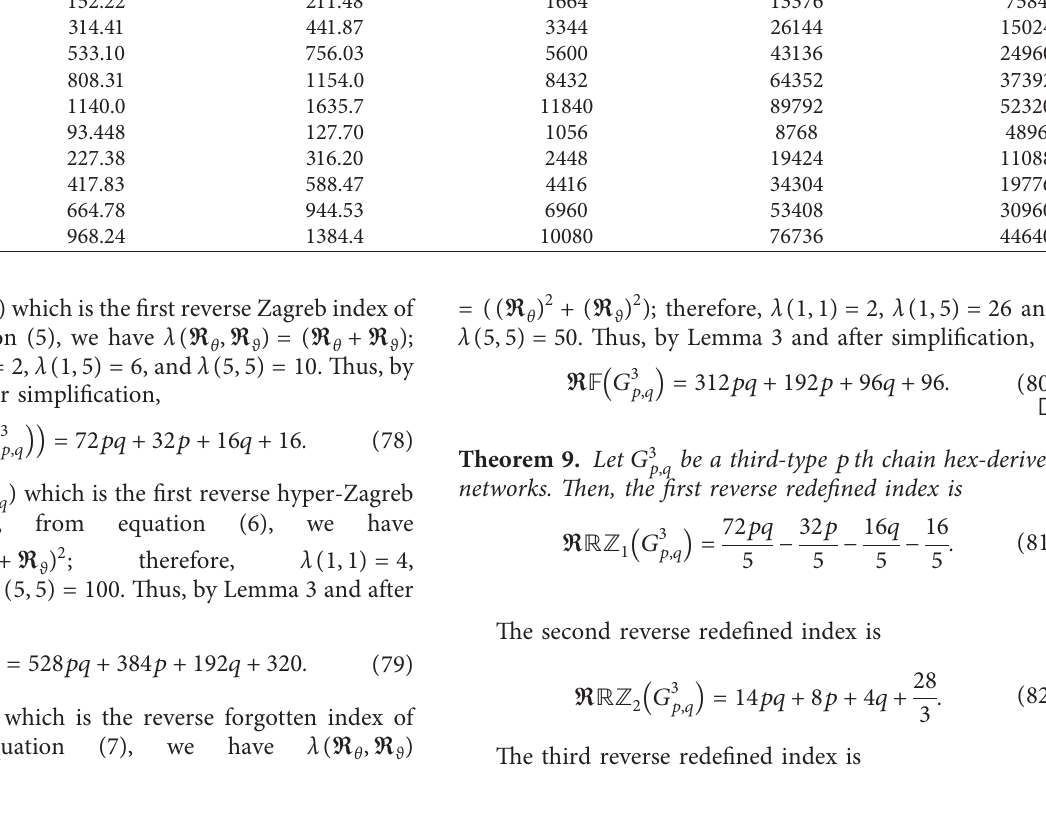
Table 3: Numerical comparison of R ABC , R GA , R M